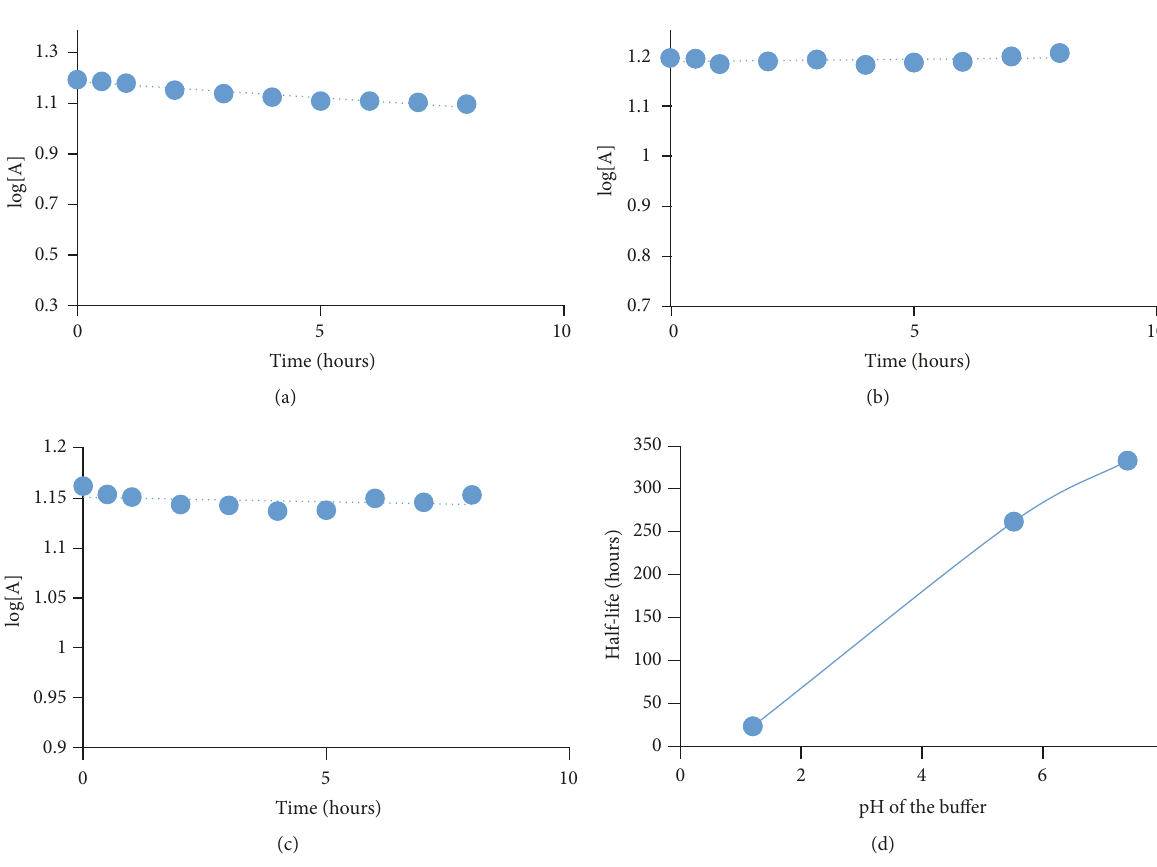
Figure 8: Hydrolysis of pro-NP in (a) SGF, (b) pH 7.4, and (c) pH 5.5. (d) is 𝑡 1/2 of pro-NP in different buffer solutions.